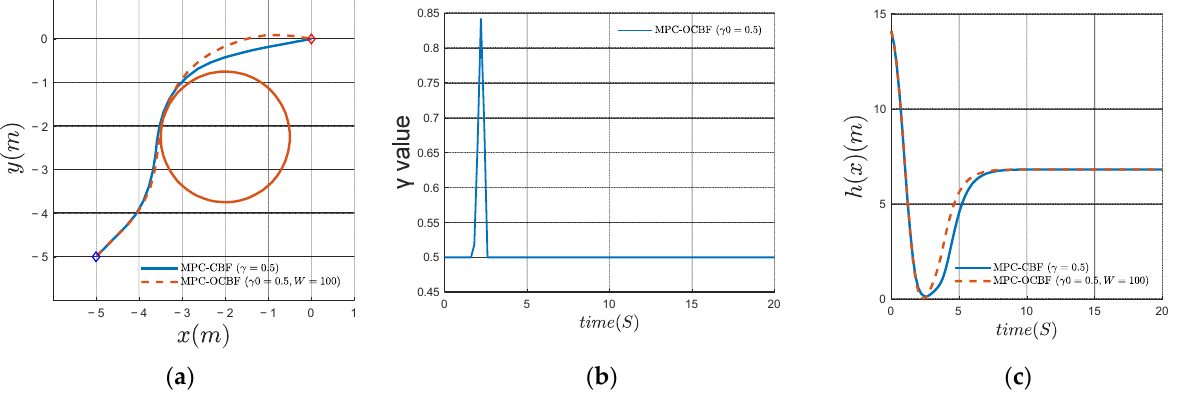
Figure 3. Compare the aggressive obstacle avoidance behaviors generated by MPC-CBF and MPC-OCBF: ( a ) the trajectory of MPC-CBF and MPC-OCBF; ( b ) the optimized γ value of MPC-OCBF with different weight matrices; ( c ) the CBF h(x) values of MPC-CBF and MPC-OCBF.